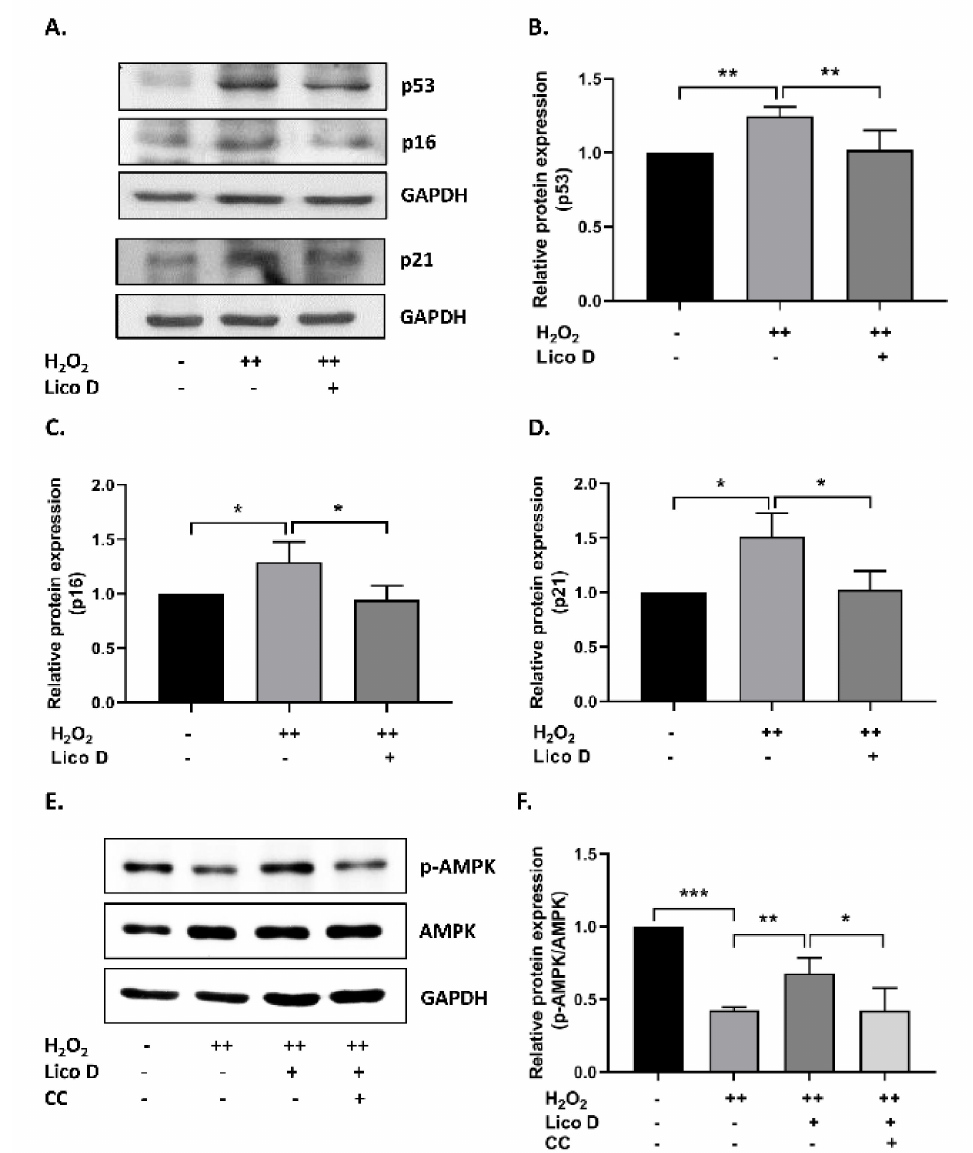
Figure 3. Lico D reduce senescence via AMPK activation in hBM-MSCs. ( A ) Representative images from immunoblot against senescence markers p53, p16, and p21 and ( B – D ) the expression level of target proteins was quantified using Image J software. ( E ) Representative images from immunoblot assay against AMPK, and phosphorylated AMPK and ( F ) the expression level of target proteins was quantified using Image J software. GAPDH was used as an internal control. Compound C (CC), an AMPK inhibitor was used. H 2 O 2 (+) represents one-time treatment and H 2 O 2 (++) represents double time treatment. The scale bar represents 100 µ m. All data are represented as mean ± SD ( n = 3) * p < 0.05, ** p < 0.01, and *** p <